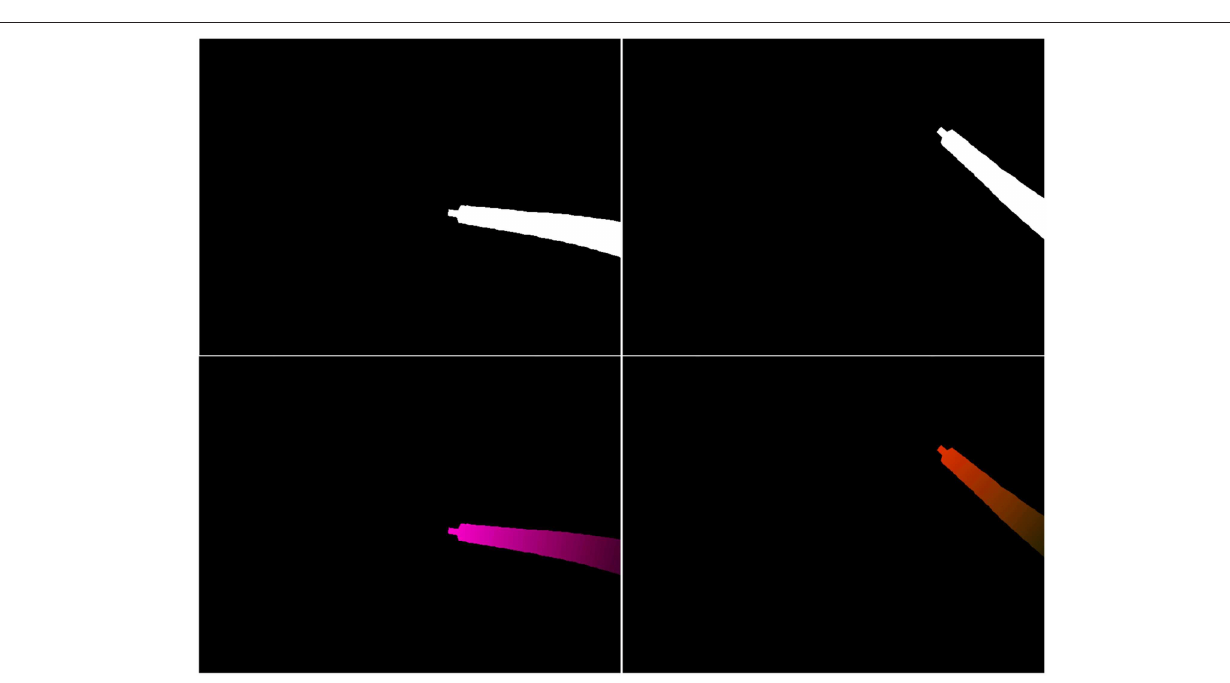
FIGURE 5 | Example of projected mask M (top row) and virtual optical flow maps F v (bottom row). (Left) Output of the kinematic model for a given q and dq . (Right) Output of the model for q + δ and the same dq